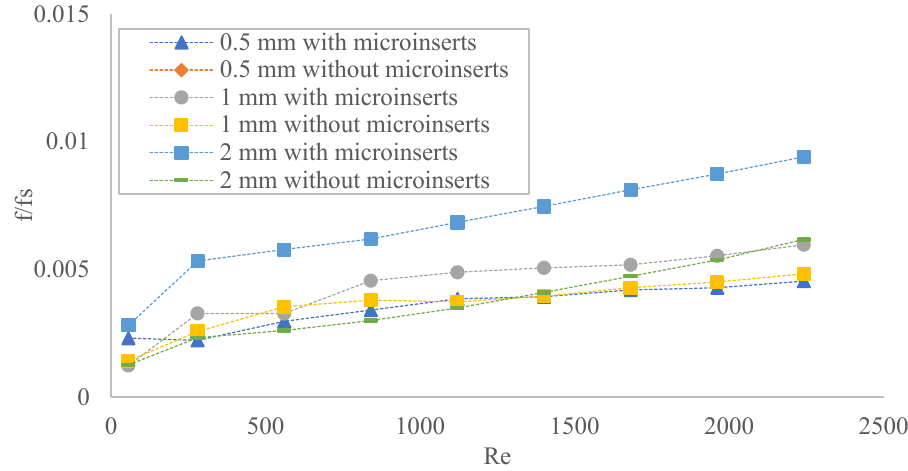
Figure 9. Variation of f/f s with Reynolds number.